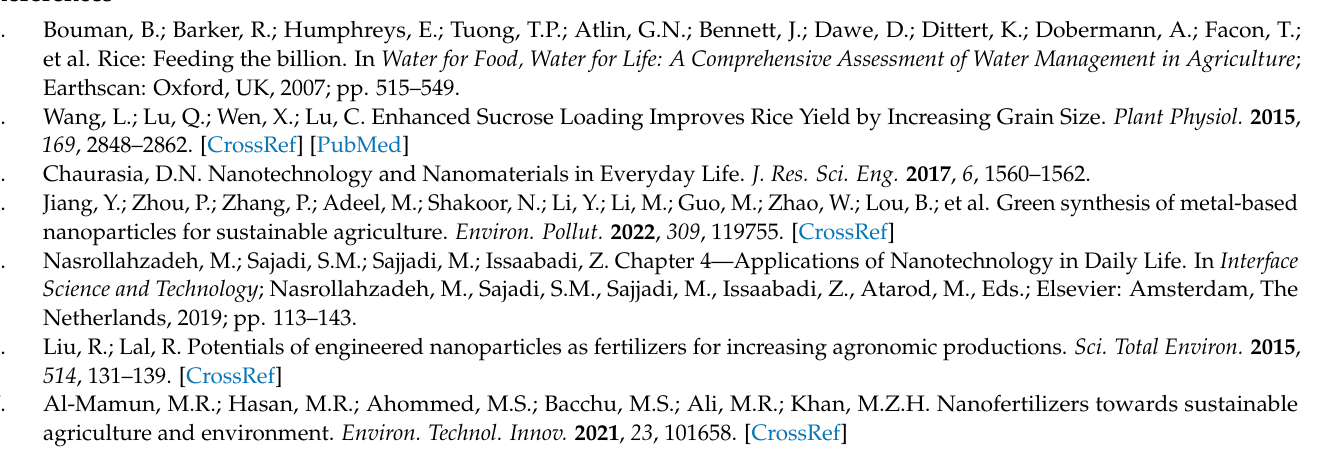
Figure S2: FTIR spectra of SiO 2 NMs (A) and SiC NMs (B); Figure S3: Images of rice leaves (A) and roots (B), Table S1:The composition of Kimura nutrient